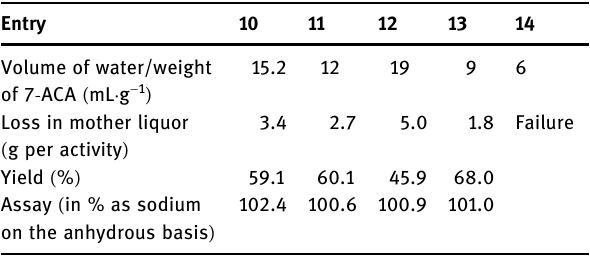
Table 3: E ff ects of the water content on the quenching step and loss of product in mother liquor